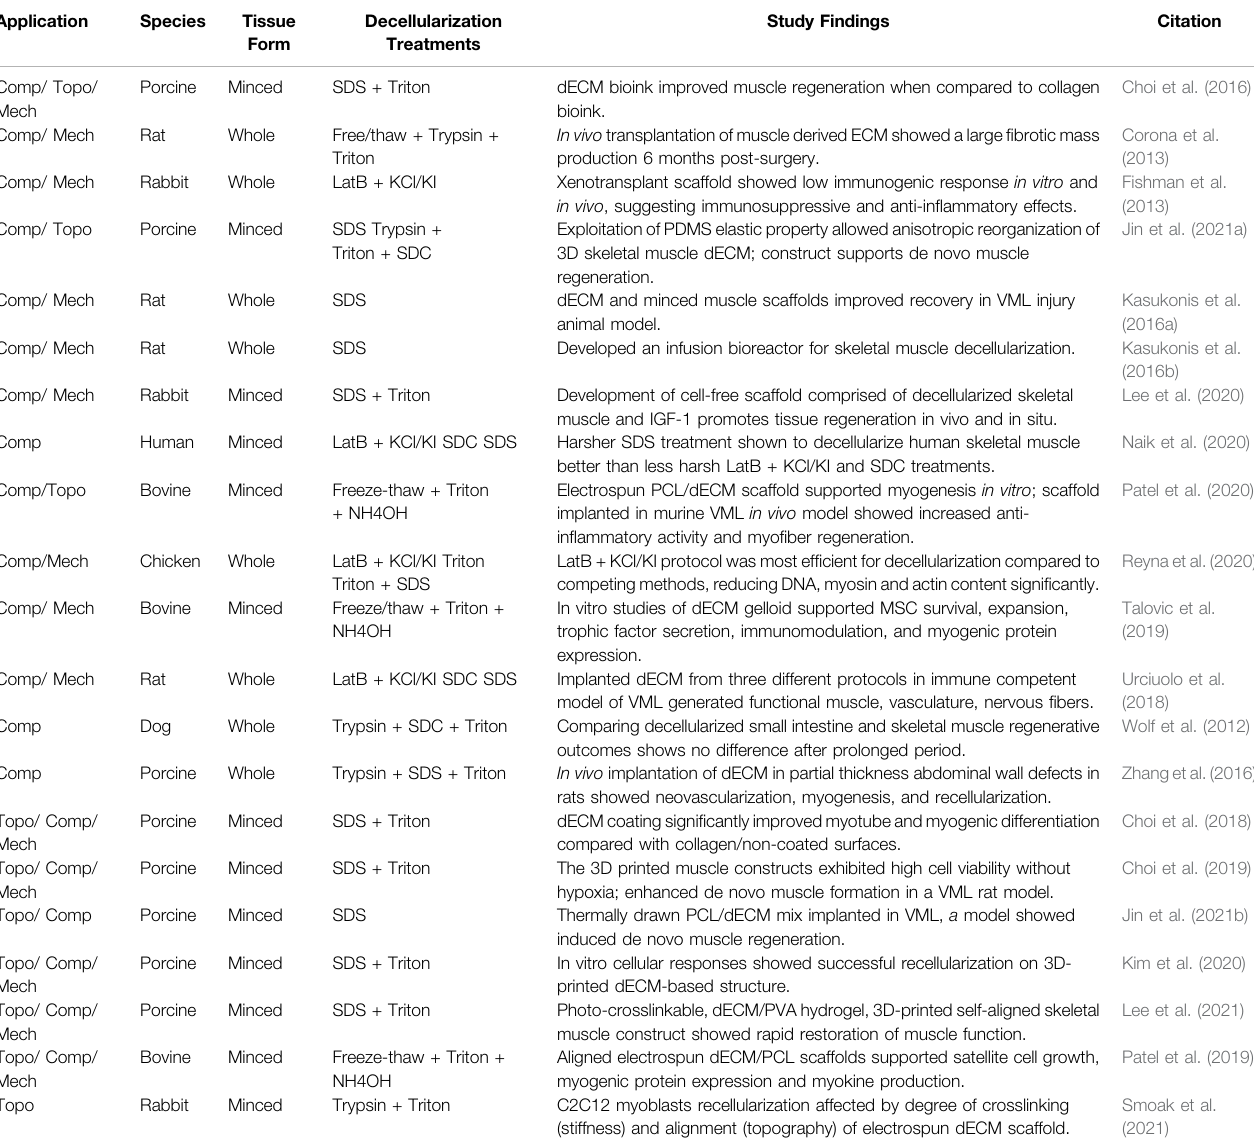
TABLE 2 | Skeletal muscle decellularization protocols. Application Species Tissue